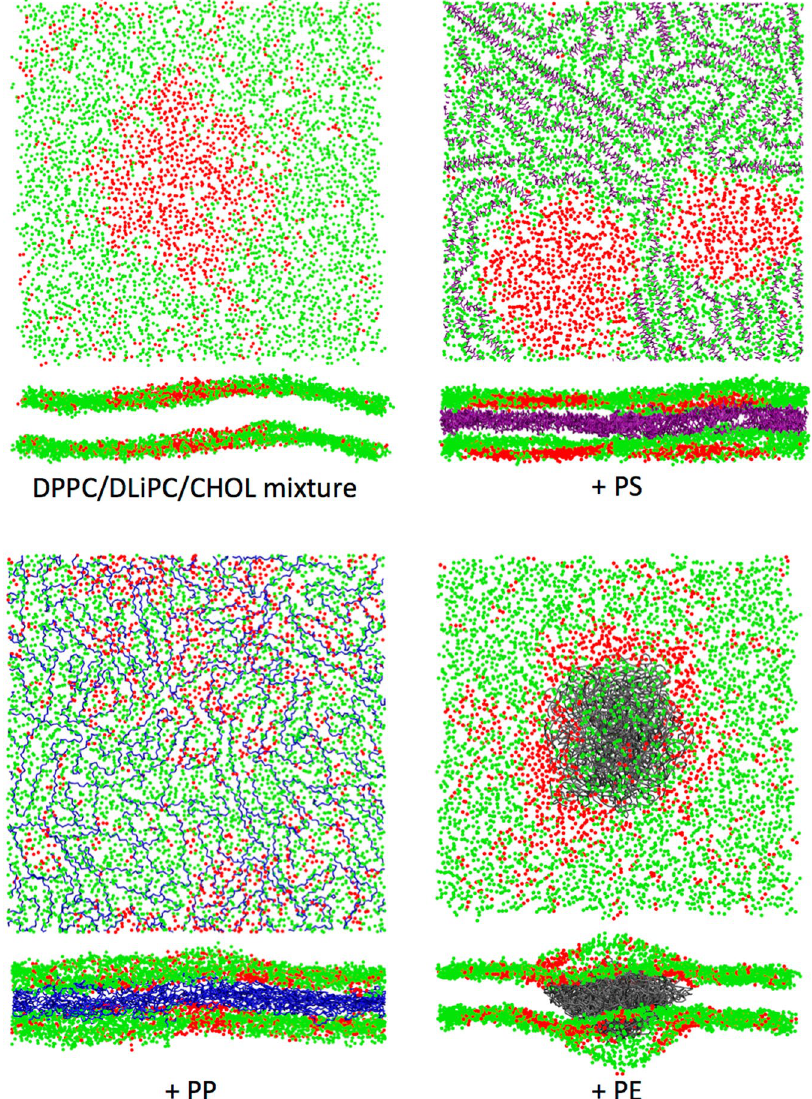
Figure 4. The three polymers in liquid-ordered/liquid-disordered phase separated membranes. Top left: top view of the phase separated ternary mixture. Only 1 bead per lipid is shown, from the head group. DPPC is shown in red, DLiPC in green, and CHOL is not shown for clarity. Top right: membrane + PS100 chains (in purple). Bottom left: membrane + PP107 chains (in blue). Bottom right: membrane + PE80 chains (in gray). When the polymer is present, its concentration is 9.7% (polymer/lipid mass ratio).